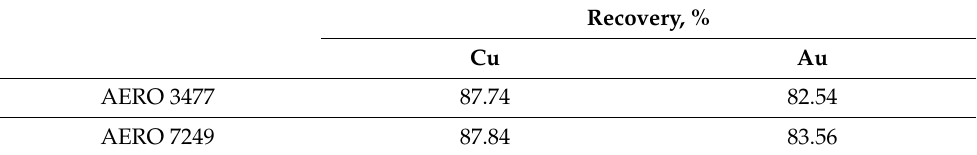
Table 5. Comparison of laboratory flotation performance between AERO 3477 and AERO 7249